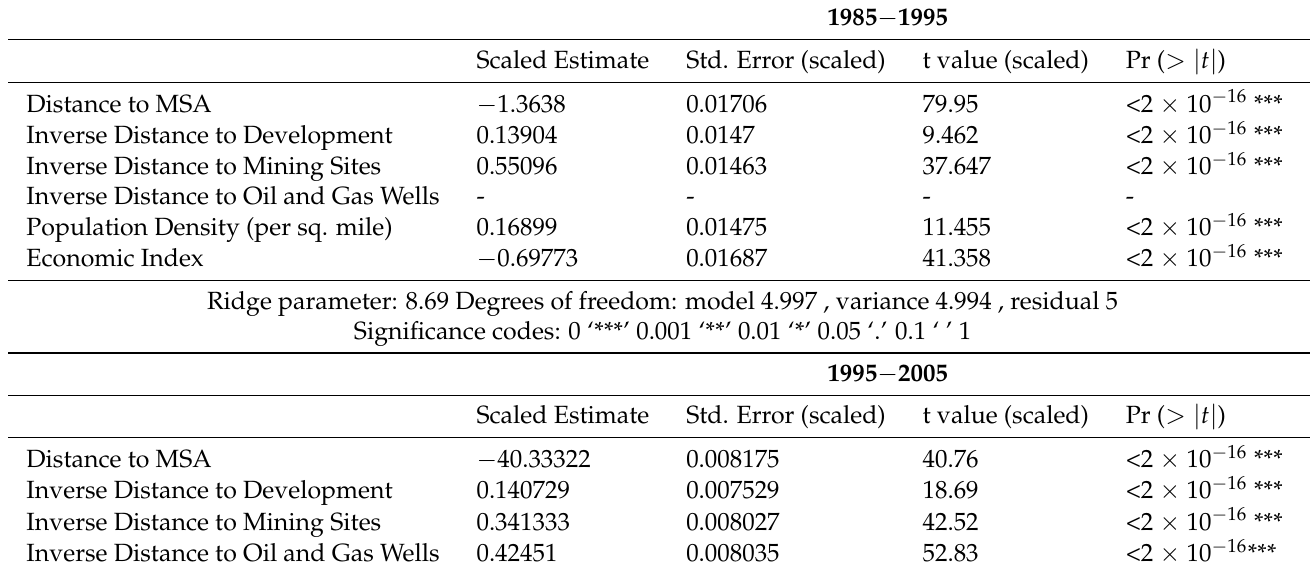
Table 5. Summary of Ridge Regression Model